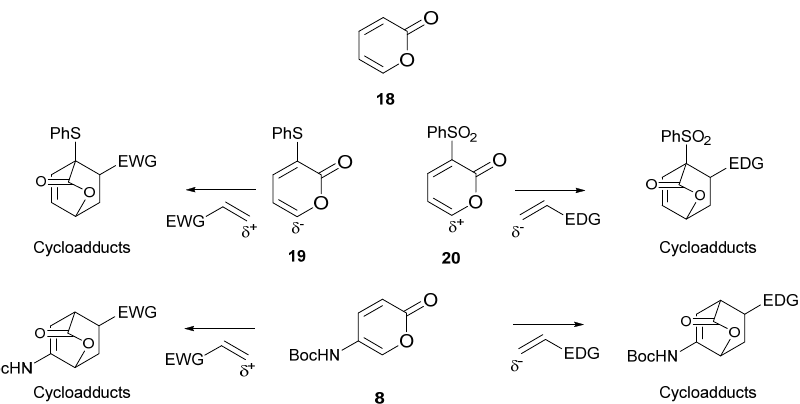
Figure 2. Electron demand in the cycloadditions of 3-phenylsulfenyl-2( H )pyran-2-one and 3- phenylsulfonyl-2( H